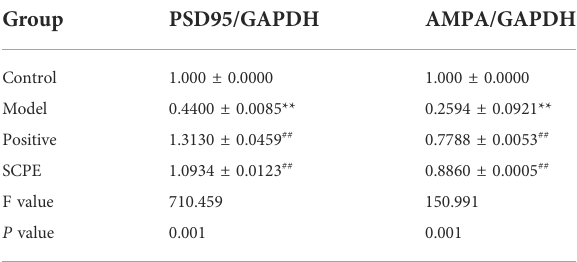
TABLE 9 Protein expression of PSD95 and AMPA in mouse hippocampus (mean ± SD, n = 3).